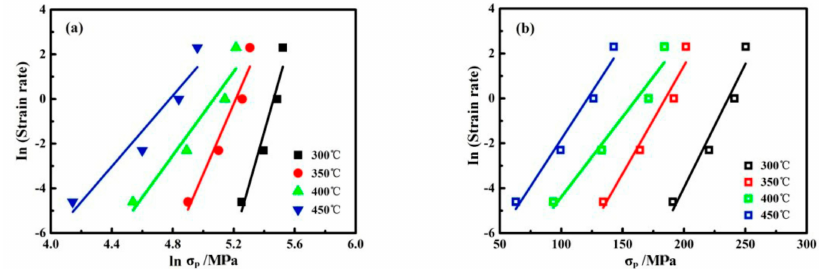
Figure 7. Relationship between ( a ) ln E and ln σ p and ( b ) ln E and σ p